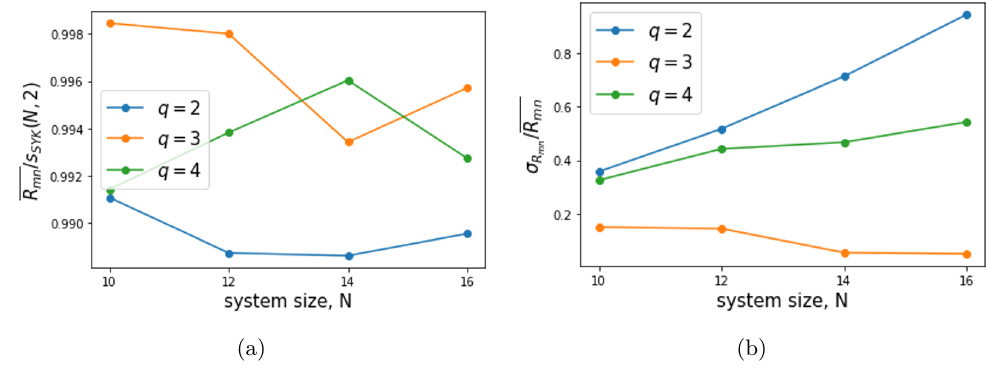
Figure 19 . Comparison among the average and the standard deviation of the R mn matrix of the q = 2 , 3 , 4 SYK model. The degree of locality is k = 4 . Each data point comes from a single realization of the